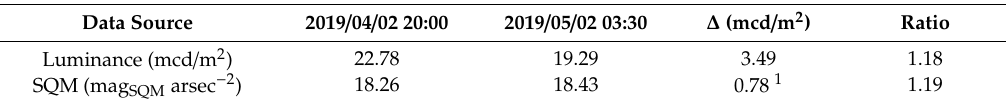
Figure 6. The upper row shows the all-sky RGB images at Padova, Italy, for a clear sky on 4 February 2019 at 20:00 local time and 5 February 2019 at 03:30 local time. The middle row shows Table 5. Average luminance in red sector of Figure 6, compared with the zenith NSB from Figure 7 on luminance maps for the same time. The lower row shows the difference between luminance the nights of 4 February 2019 and 5 February 2019. obtained from subtracting images. The orange arrow indicates Sant’Antonio ’s church.